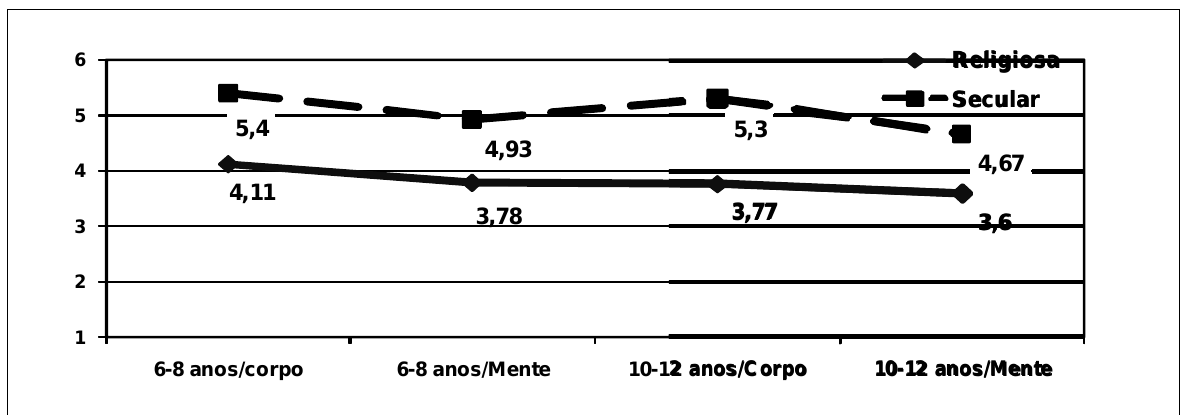
Figura 1 . Média das respostas do tipo “não funciona” em função da Idade, Narrativa (Secular versus Religiosa) e Tipo de processo (Corpo versus